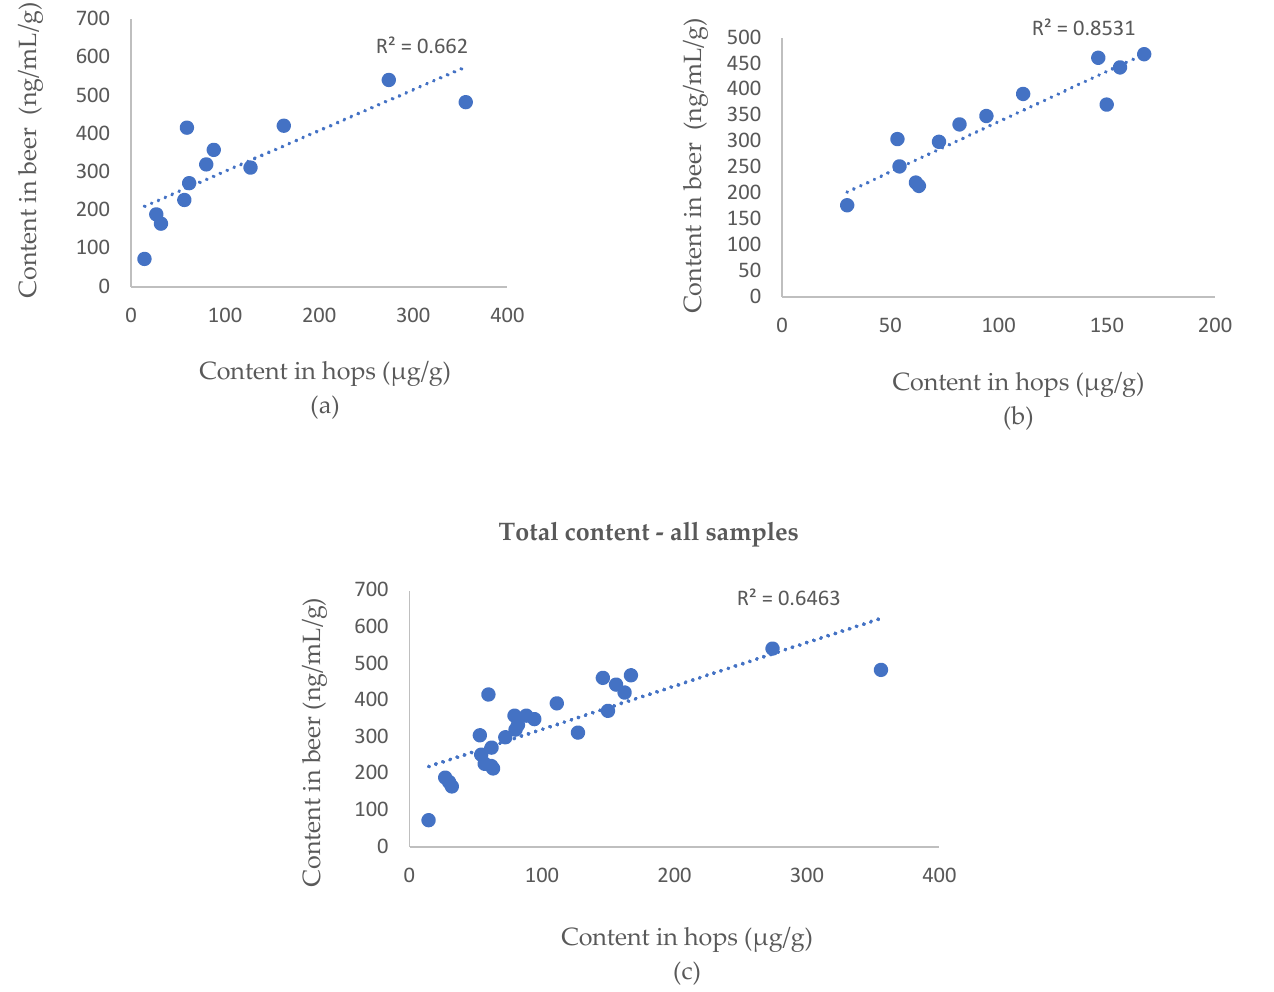
Figure 3. The total content of the selected prenylflavonoids in hops plotted against the total content of selected prenylflavonoids in beer in the ( a ), organic samples ( a ), conventional samples ( b ) and whole sample group ( c ).